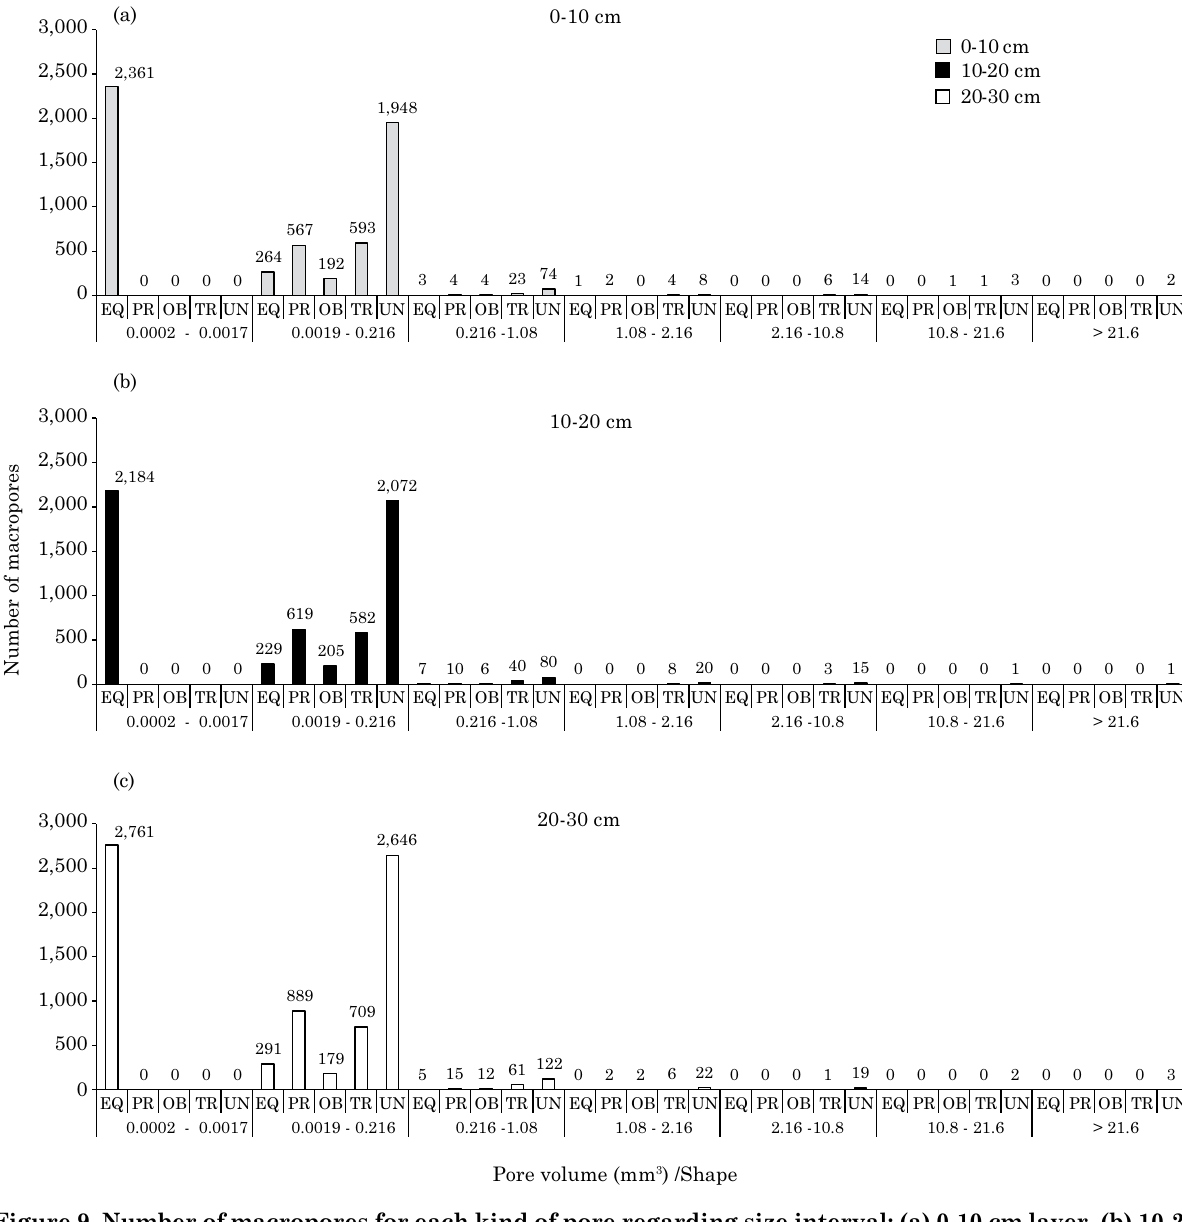
figure 9. Number of macropores for each kind of pore regarding size interval: (a) 0-10 cm layer, (b) 10-20 cm layer, and (c) 20-30 cm